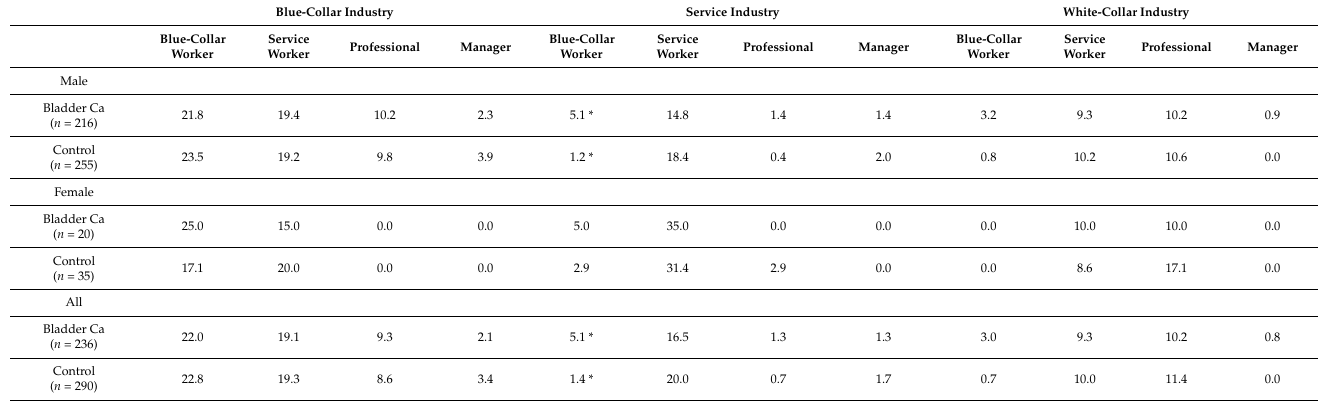
Table 4. Distribution of groups in the Zaitsu